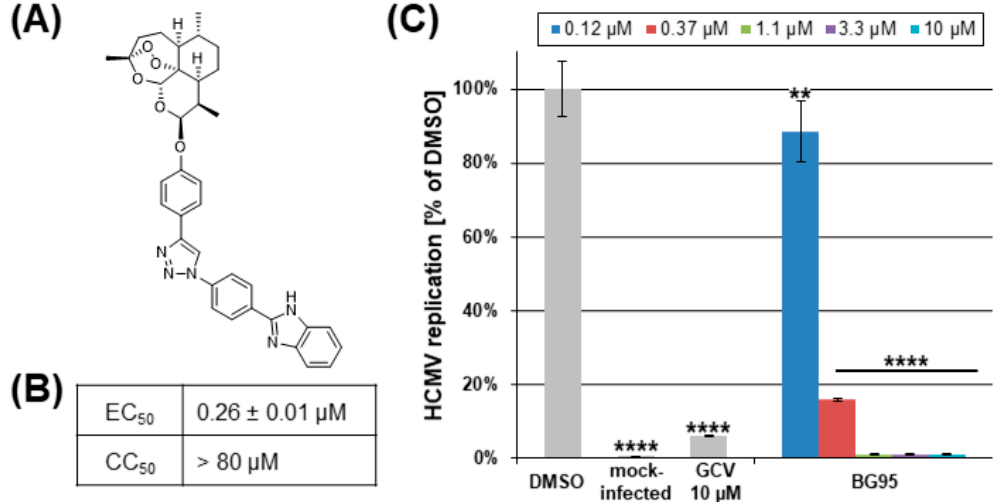
Figure 1. Assessment of BG95 anti-HCMV activity and cytotoxicity levels in vitro. ( A ) Chemical structure of BG95. ( B ) HCMV-specific EC 50 and CC 50 values of BG95 (the latter measured by neutral red assay; Figure S1B). ( C ) Anti-HCMV efficacy of BG95 measured by the HCMV GFP-based replication assay performed with primary human fibroblasts (HFFs), as compared to solvent control (DMSO), mock-infected cells and reference inhibitor ganciclovir (GCV, 10 µM). Statistical analysis was performed using ordinary One-way ANOVA and post-hoc Tukey’s test compared to DMSO. ** p < 0.01; **** p < 0.0001.